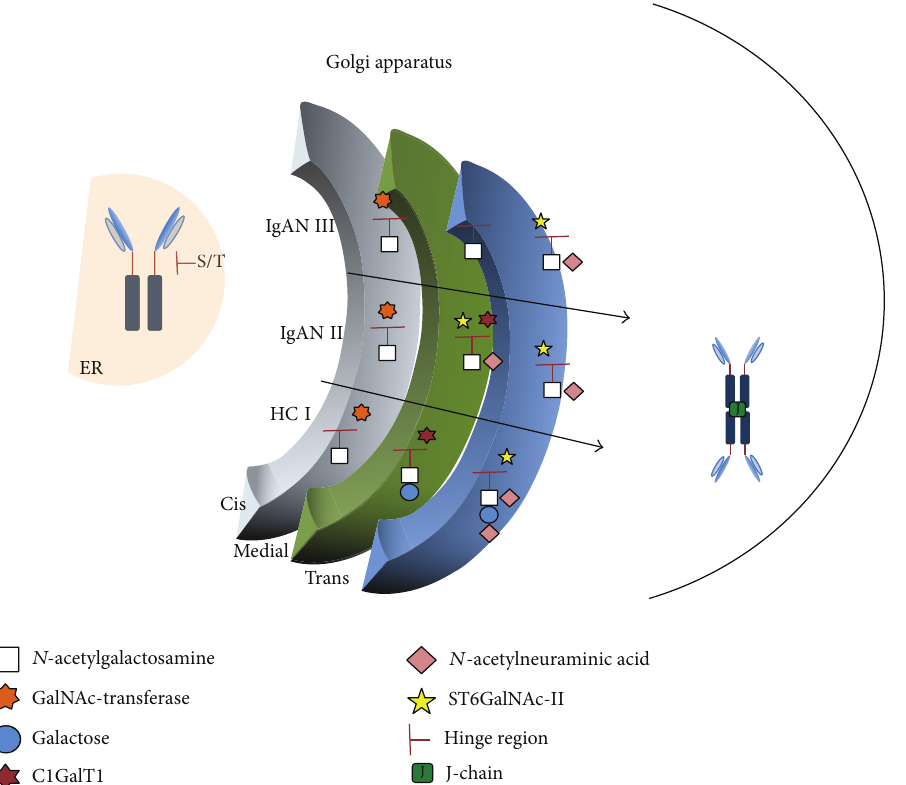
Figure 2: Pathways of IgA1 O -glycosylation. The hinge region of IgA1 is O -glycosylated in the Golgi apparatus, a structure composed of multiple layers compacted together, with three designated regions: cis, medial, and trans. These structures support differential localization of various glycosyltransferases, an arrangement that confers a level of specificity and order of addition of sugar moieties. Path I shows normal (in healthy controls; HC) sequential addition of N -acetylgalactosamine (GalNAc), galactose (Gal), and N -acetylneuraminic acid (NeuAc) by their respective enzymes, GalNAc-transferase, core 1 galactosyltransferase (C1GalT1), and sialyltransferases, ST6GalNAc-II (adds NeuAc to GalNAc) and/or ST3Gal (adds NeuAc to Gal). There are multiple GalNAc-transferases that can initiate IgA1 O -glycosylation. Path II shows a possible deviation in the localization of ST6GalNAc-II that could lead to a galactose deficiency due to premature sialylation of GalNAc. The addition of sialic acid blocks a later addition of galactose. Path III shows a scenario in which a reduced expression of C1GalT1 in IgA1- secreting cells from IgAN patients would decrease the addition of galactose to IgA1. Pathways II and III represent possible deviations from normal glycosylation that could lead to production of galactose-deficient IgA1. The polymeric form of IgA1 is formed after exit of IgA1 from the Golgi apparatus through the addition of J chain that binds covalently to the tail pieces of the heavy chains. The resultant polymeric IgA1 may be a dimer or higher